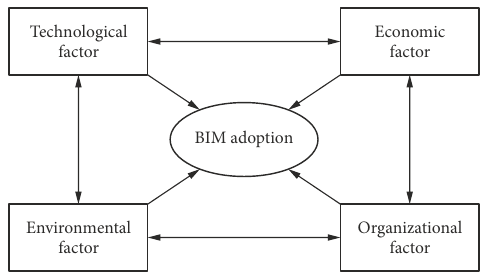
Figure 2. Improved TOE framework of BIM technology